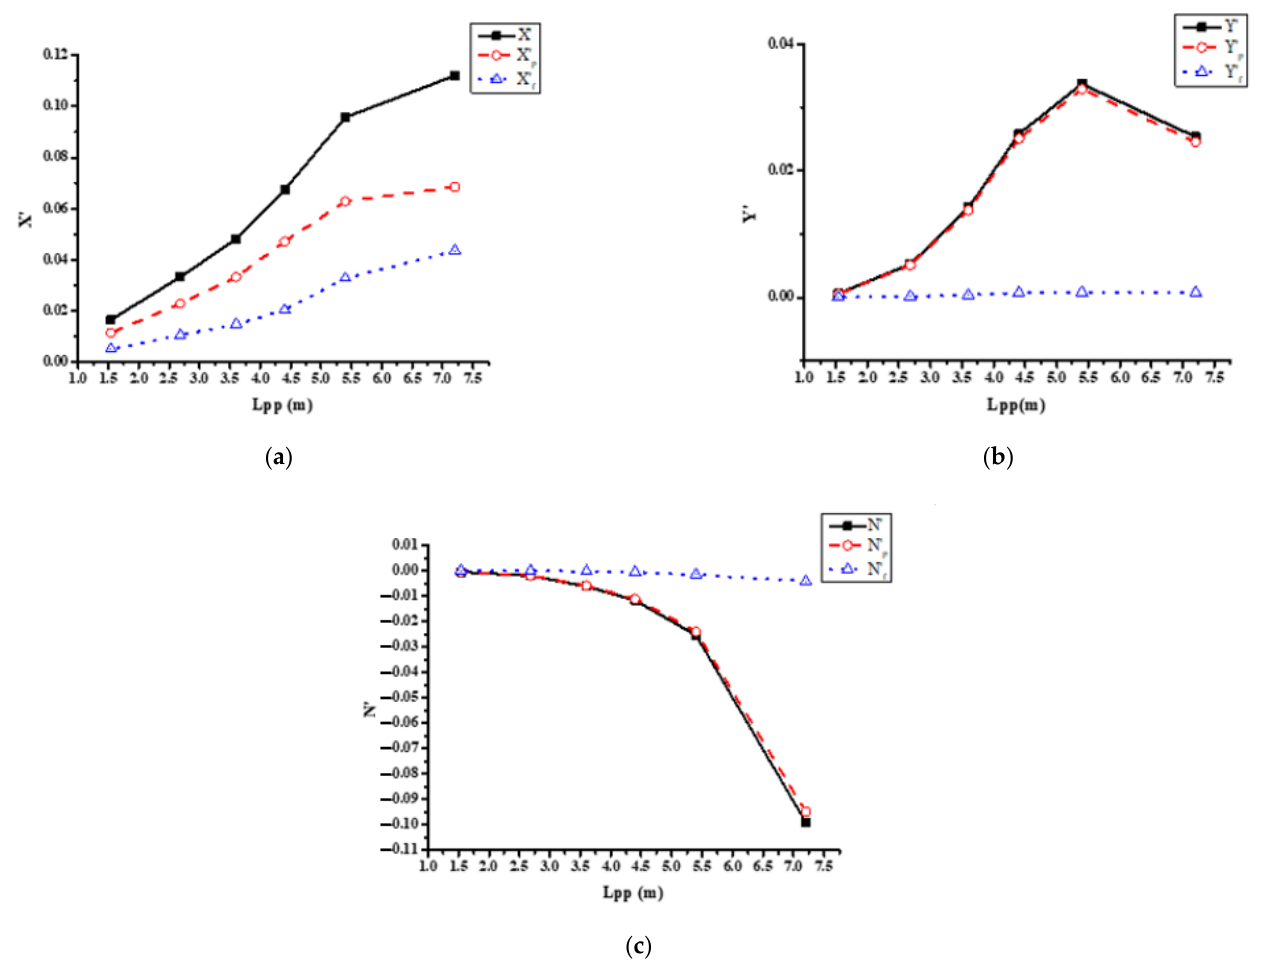
Figure 14. Non–dimensional results of ship type on ship hydrodynamics ( a – c ): resistance force, sway force, yaw moment